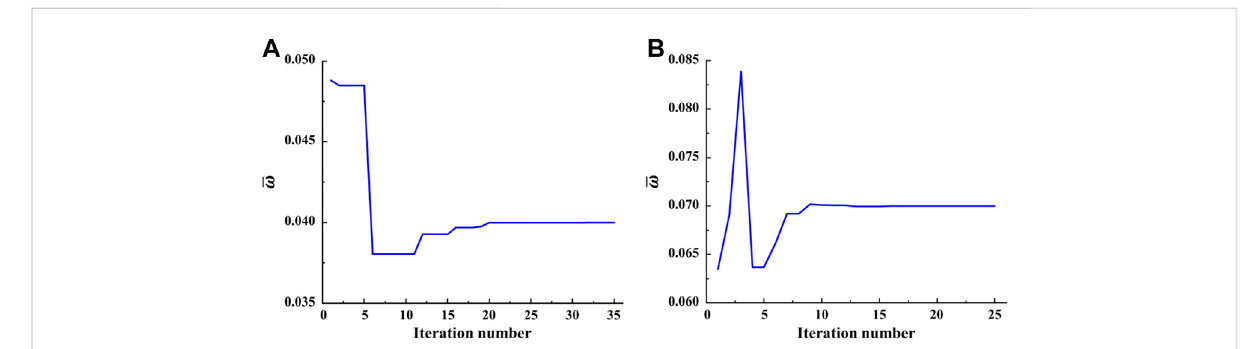
FIGURE 8 Iteration histories of the width of the normalized common bandgap for target values of (A) 0.04 and (B) 0.07.